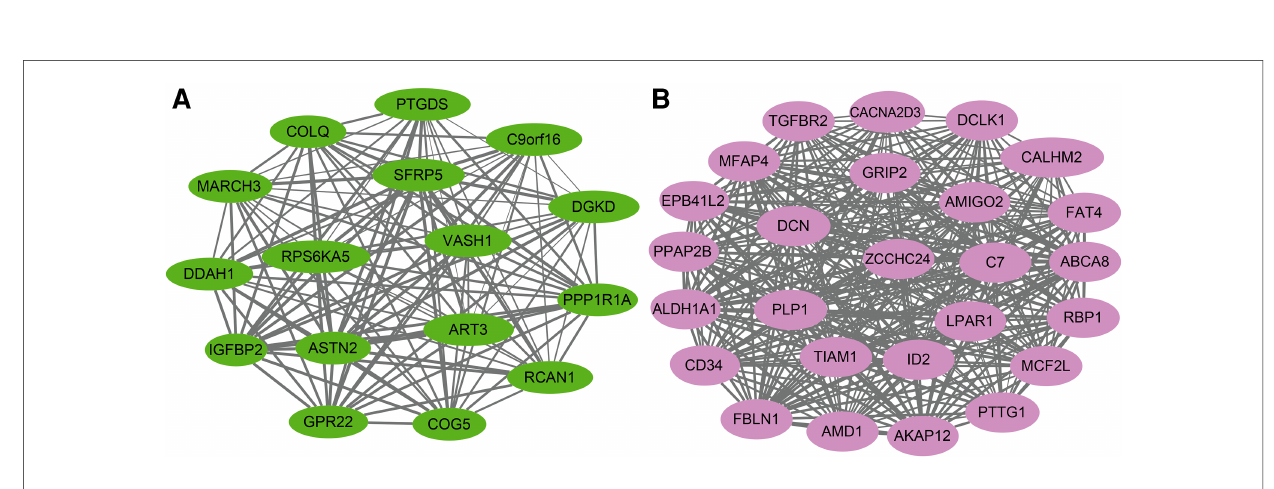
FIGURE 6 Go and KEGG enrichment analysis of green and pink modules. ( A ) GO analysis of biological process of green module. ( B ) GO analysis of biological process of pink module. ( C ) KEGG pathway analysis of green module. ( D ) KEGG pathway analysis of pink module. The size of the bras represents the number of genes, and the color of the dots represents the − log10( P ) value, the x -axis represents the RichFactor of genes.